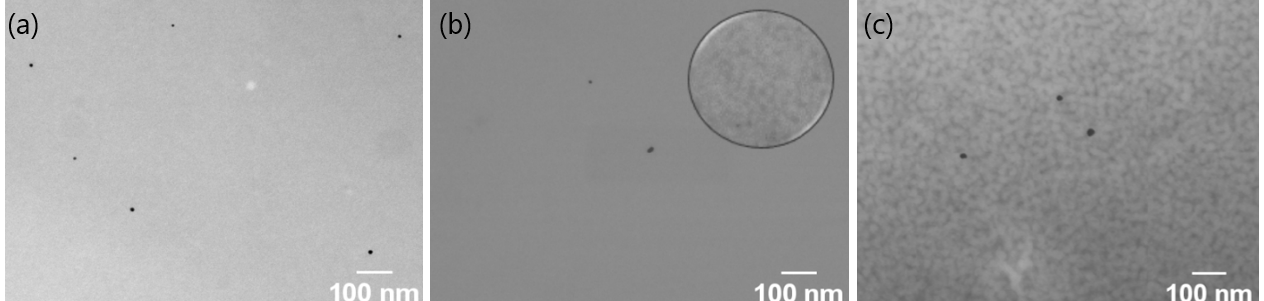
Figure 6. STEM micrographs of the nanocomposites prepared by drying at 36 °C: ( a ) PAM- b -PNIPAM- b -PAM-Au1; ( b ) PAM- b -PNIPAM- b -PAM-Au2; ( c ) PAM- b -PNIPAM- b -PAM-Au3. It is observed that by increasing the length of the PNIPAM block, the self-assembly process is favored, generating structural arrangements.